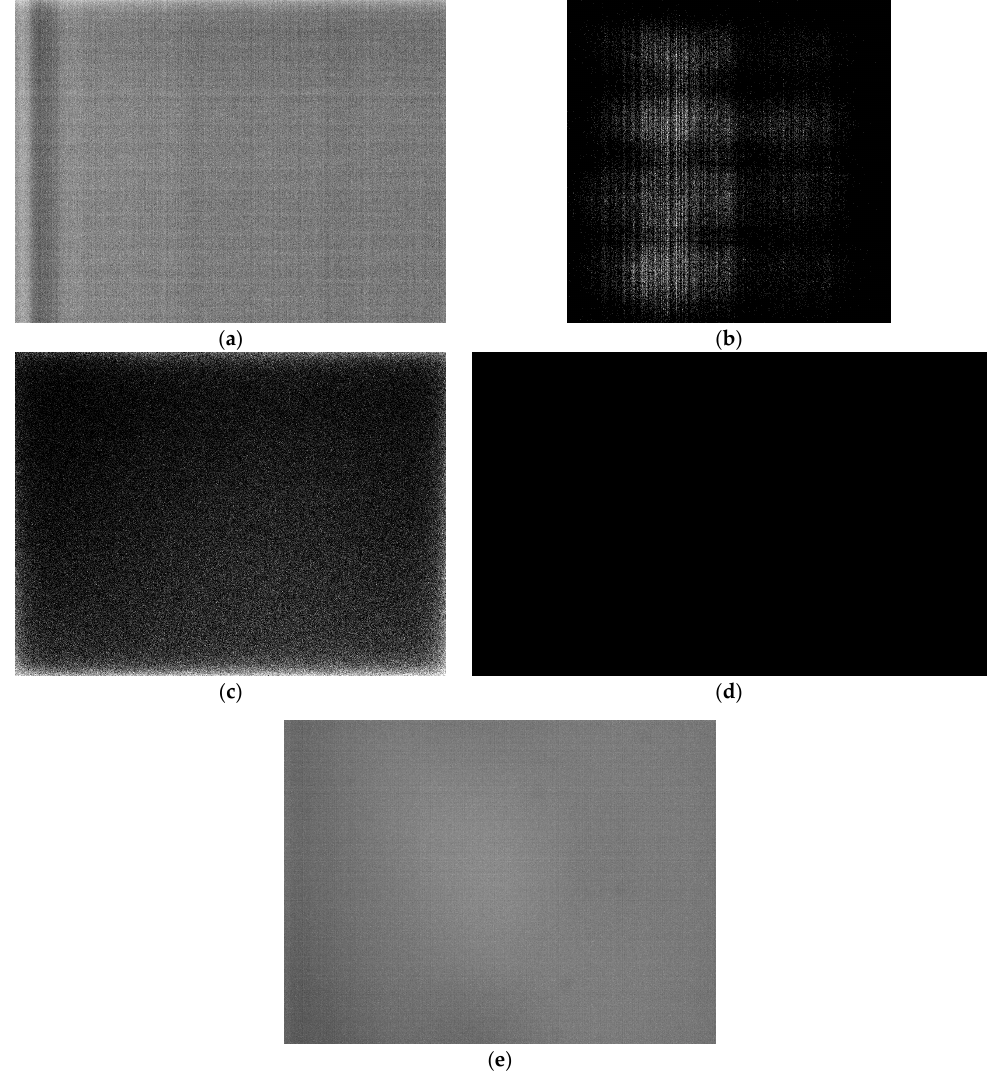
Figure 10. Fixed-pattern noise found in averaged 100 ms dark exposure images. ( a ) PCO.1600 image scaled between 92–104 counts, ( b ) Basler Ace image scaled between 0–2 counts, ( c ) Basler Dart image scaled between 0–24 counts, ( d ) Genie Nano image scaled between 0–1 counts and ( e ) XiMU image scaled between 163–178 counts.